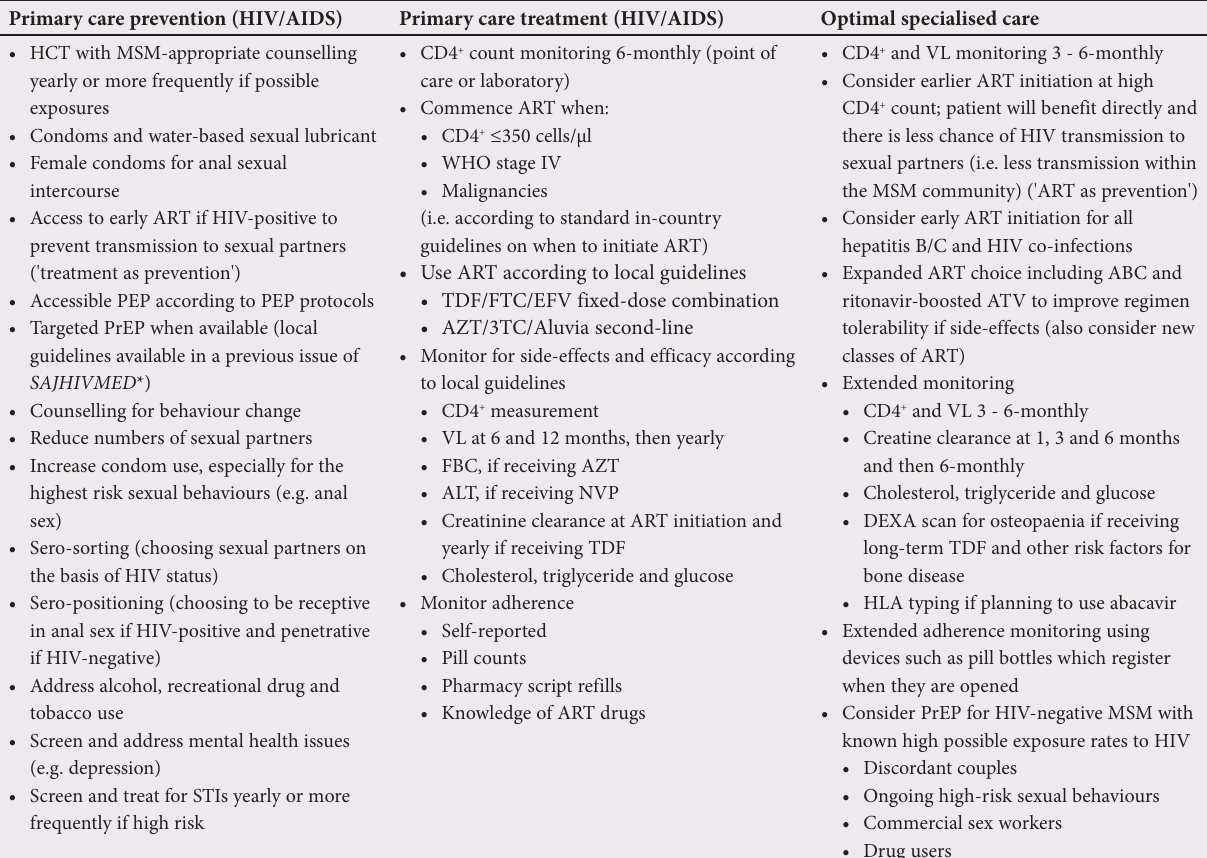
Table 1. Recommended service package for addressing the sexual health of MSM: HIV/AIDS Primary care prevention